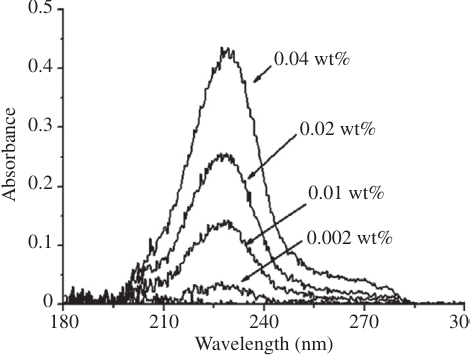
) as a function of Figure 6 Mean mineral oil slug length ( L mean × 10 3 ) measured the dimensionless dispersant injection rate ( Θ D by analyses of microscope images. The transition from stable, well-characterized slug flows to the bubbly microfluidic regime is illustrated each for Model Dispersant I, II, and III. Figure 7 UV-vis absorbance of sodium benzoate in